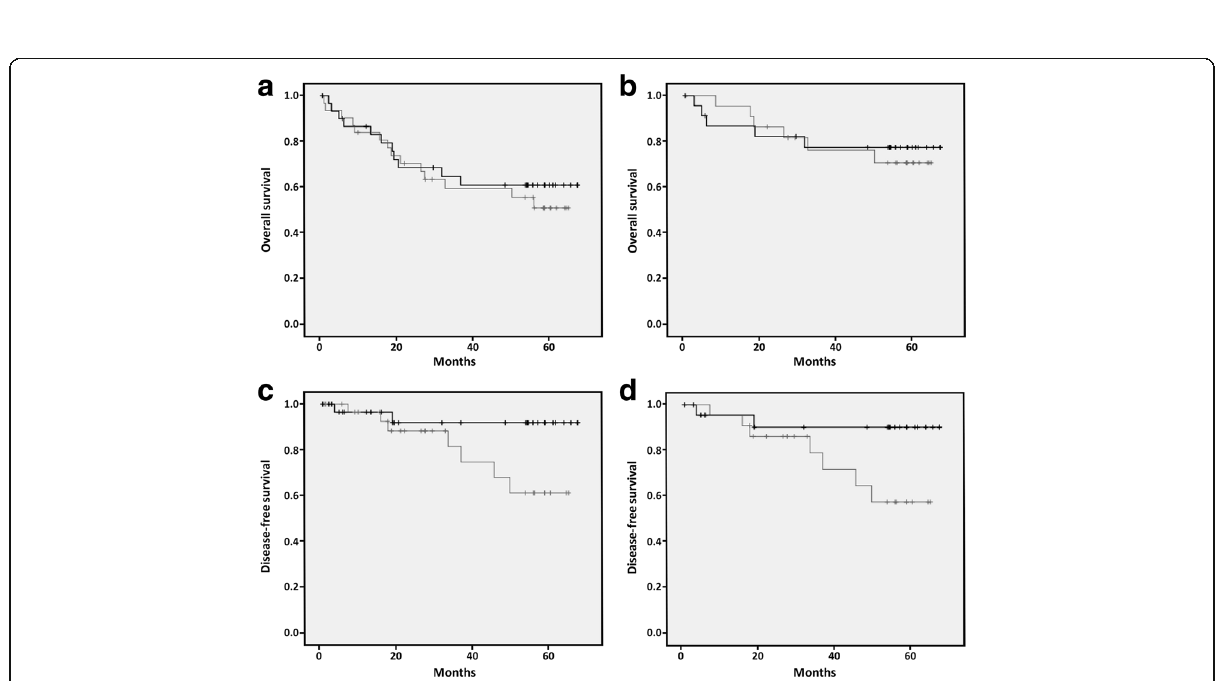
Fig. 4 Correlation between GAPDH expression and patient survival. a Kaplan-Meier plot correlating GAPDH expression and survival in patients with colorectal cancer ( P = 0.609). b In patients with non-metastatic colorectal cancer ( P = 0.773). c Kaplan-Meier plot correlating GAPDH expression and disease-free survival in patients with colorectal cancer ( P = 0.051). d In patients with non-metastatic colorectal cancer ( P = 0.064). Black line represents the group of patients whose GAPDH expression is higher than the median values, and grey line represents those with GAPDH expression lower than the median